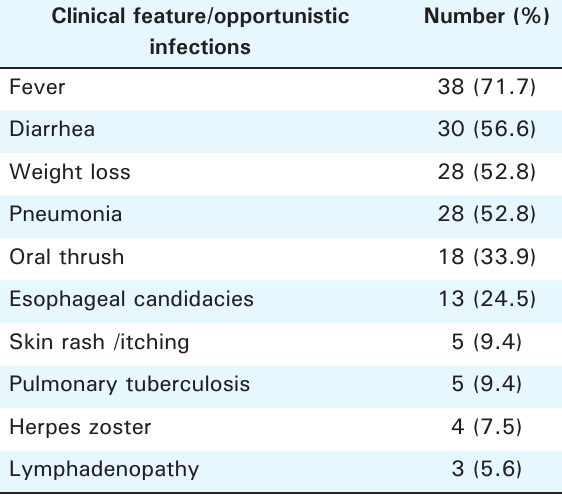
table 3. Different types of clinical presentation / Opportunistic infections in HIV patients